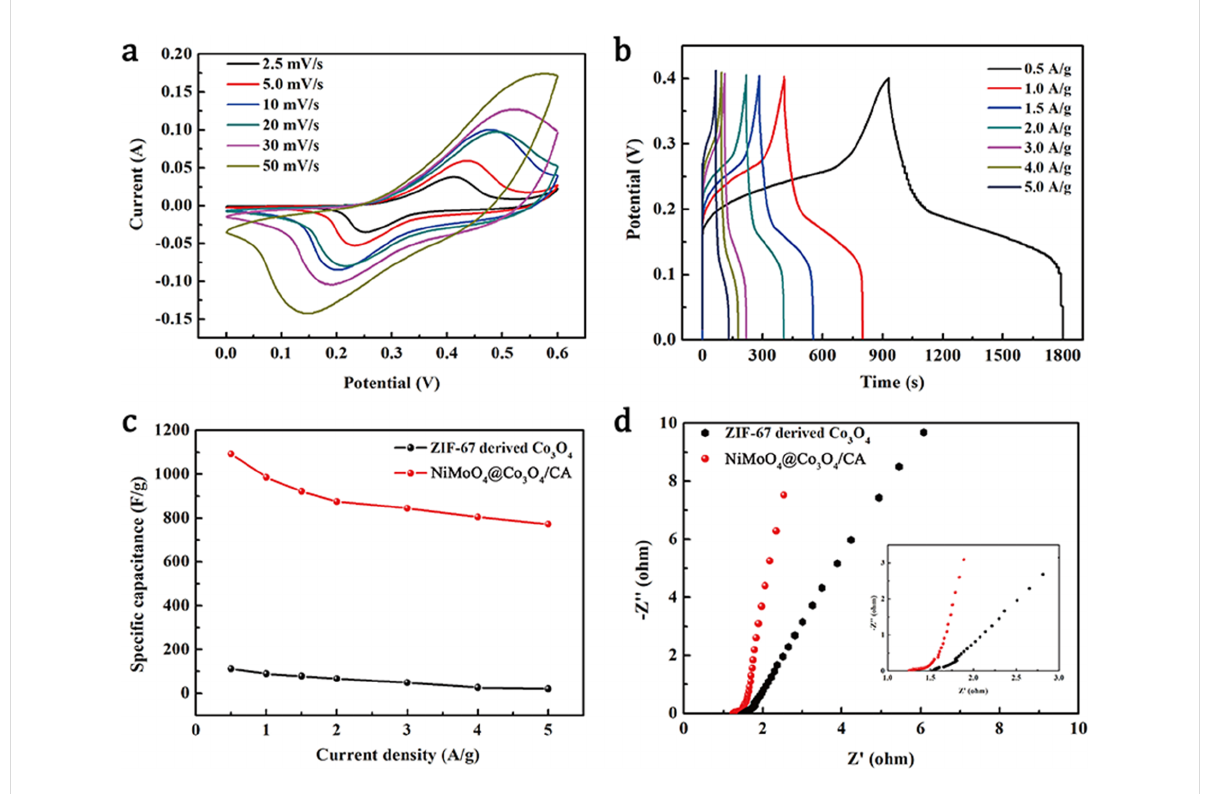
Figure 6: (a) Cyclic voltammetry (CV) curves at scan rates of 2.5–50 mV/s and (b) galvanostatic charge/discharge (GCD) curves at different values of the current density ranging from 0.5 to 5.0 A/g of the NiMoO 4 @Co 3 O 4 /CA ternary composite. (c) Specific capacitance at various values of the current density and (d) electrochemical impedance spectroscopy (EIS) plots of pure ZIF-67 derived Co 3 O 4 and NiMoO 4 @Co 3 O 4 /CA